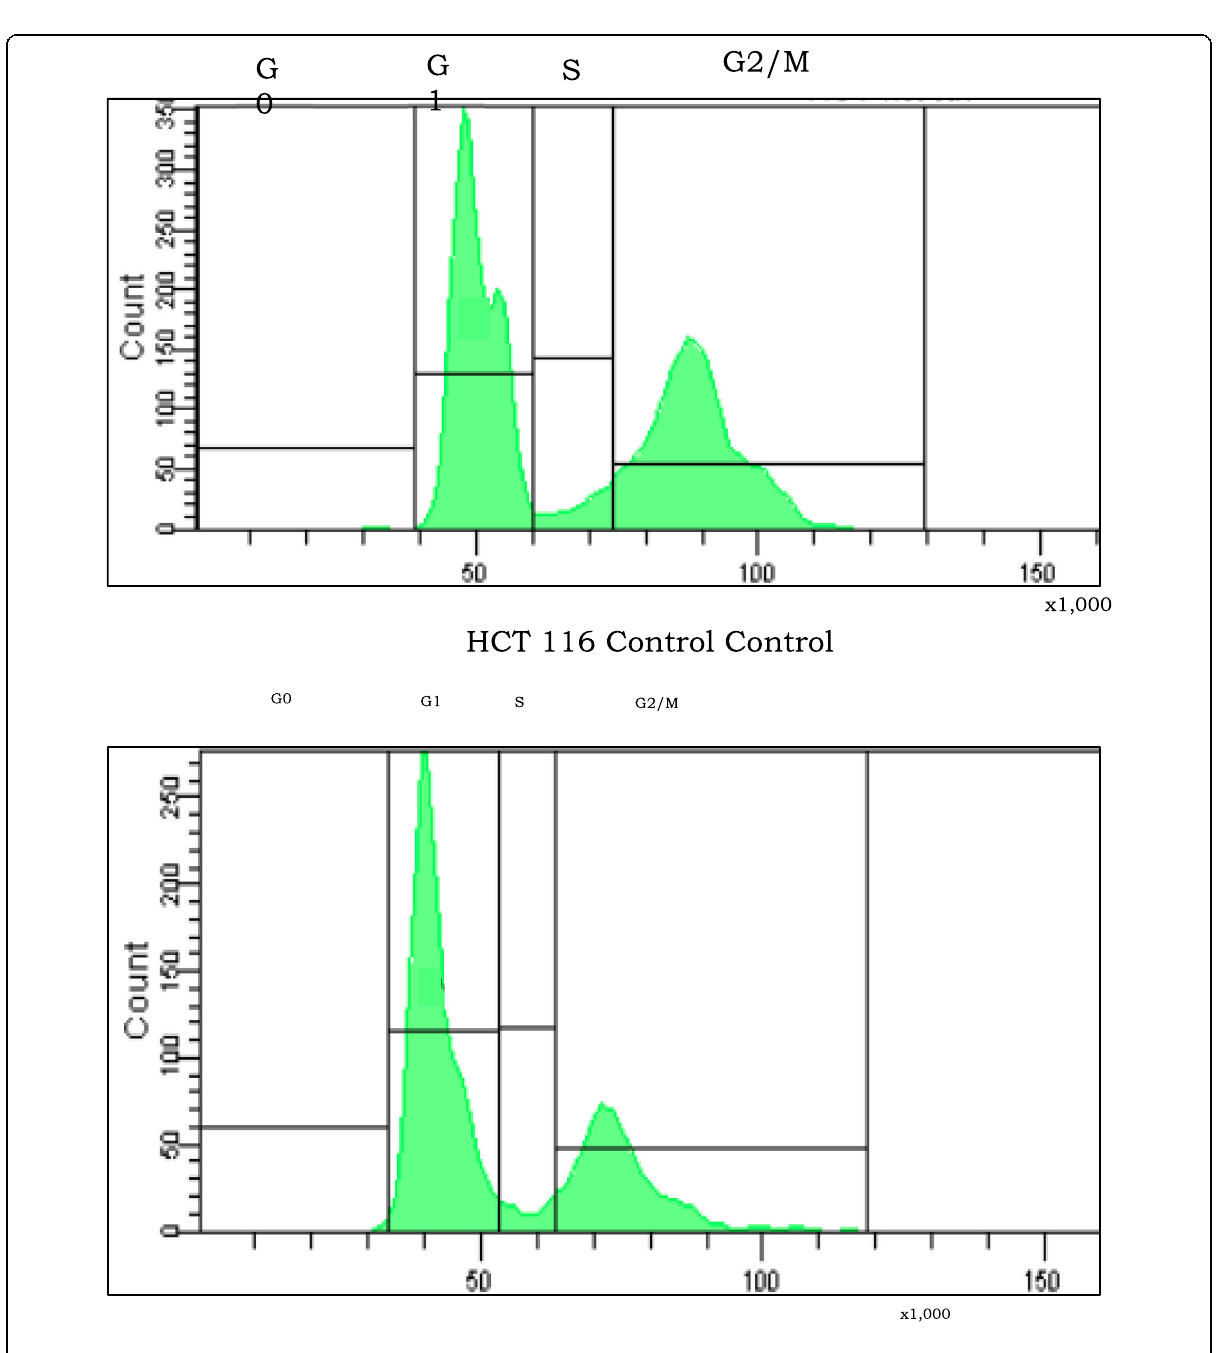
Fig. 18 Analysis of cell cycle arrest of HCT 116 cells when treated with IC 50 concentration of F. religiosa ethanolic extract (24.27 μ g/ml) and along with control IMR 32